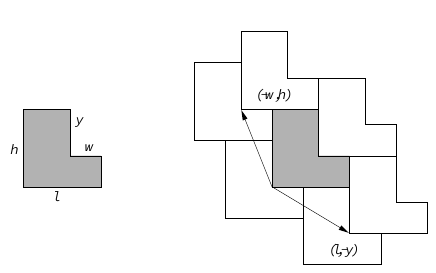
Fig. 2: Generic description of an L-shaped tile and its related tessellation